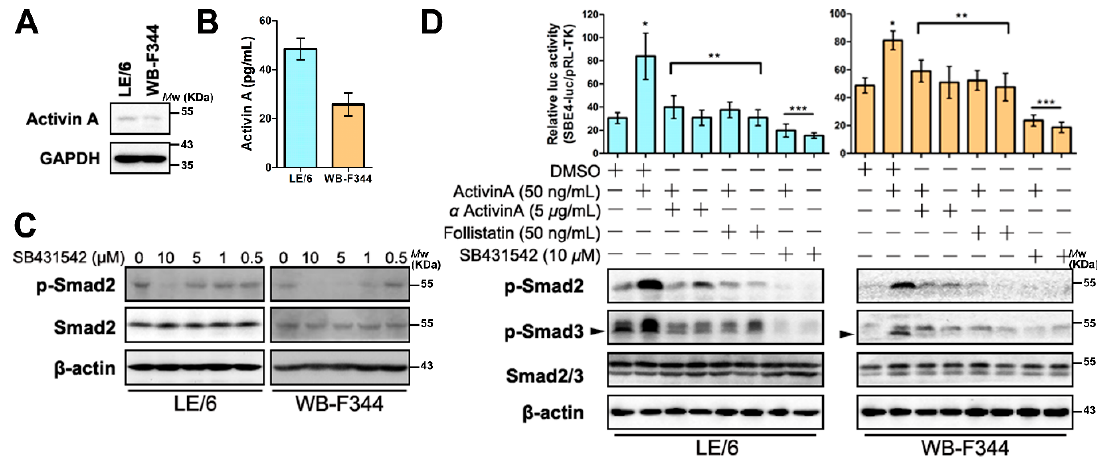
Figure 3. Cont. Figure 3.